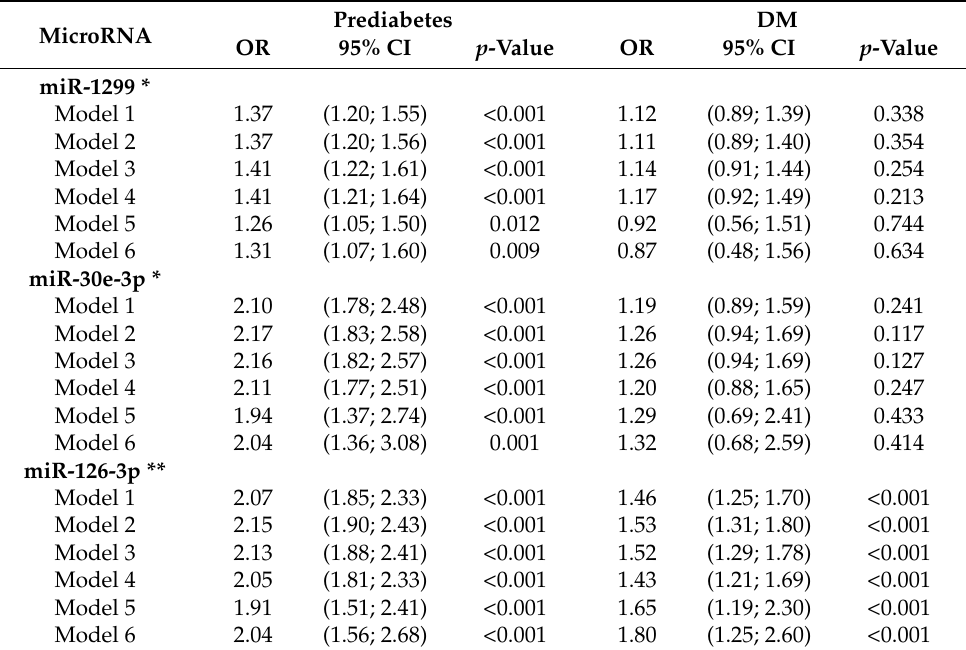
Table 4. Multivariate regression analysis of miRNAs for the presence of prediabetes and diabetes.